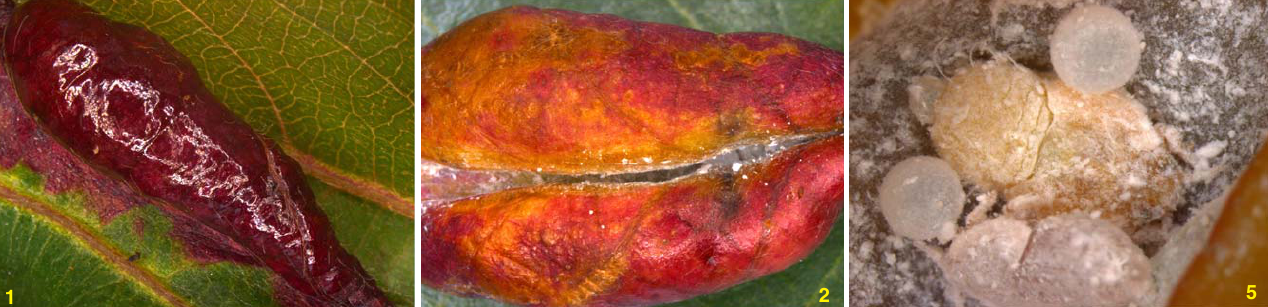
sp.1 Image 1. Marginal gall on leaf of Terminalia